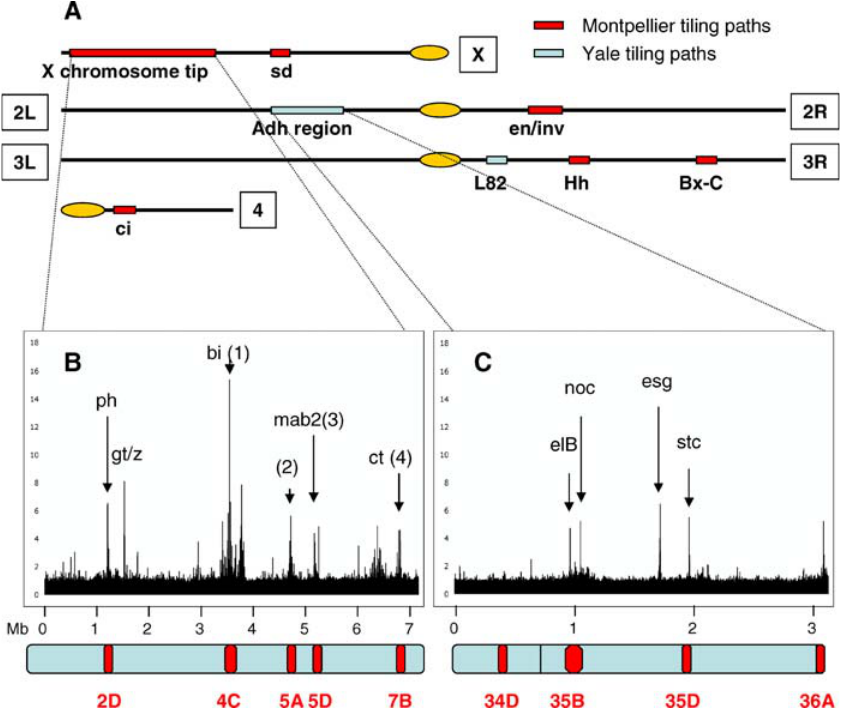
Figure 2. ChIP on Chip Mapping of the PH Protein Using MY Microarrays (A) Schematic representation of the four Drosophila chromosomes, with the Montpellier tiling path assembly shown in red, and the Yale tiling path regions shown in light blue. (B) The distribution of the PH protein along the tiling path of the X chromosome in Drosophila embryos. Numbers 1 to 4 indicate the regions for which FISH probes used in Figure 3 were designed. The ph locus is a known PcG target that served as a positive control. The other arrows point to the major binding sites. Below the graphs, a scheme of the corresponding chromosomal region is shown; with the cytological location of known PH bands in polytene chromosomes indicated as red ovals. (C) The distribution of the PH protein along the Adh region of Chromosome 2L in Drosophila embryos. Symbols are as in (B). DOI: 10.1371/journal.pbio.0040170.g002 PLoS Biology |